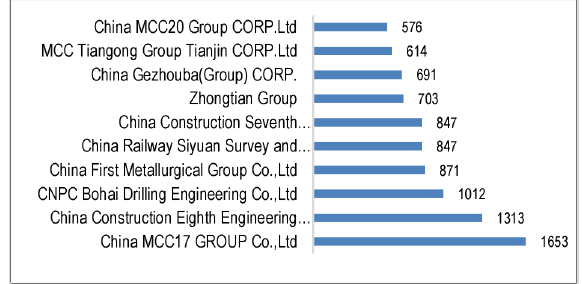
2015Figure 4. The top 10 enterprises with most number of independent R&D